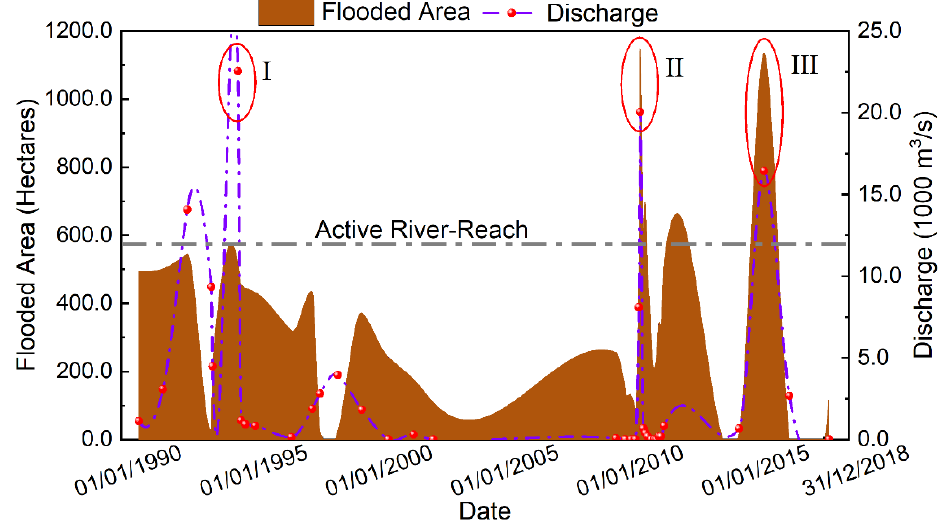
Figure 6. The relation between riverine surface area inundated with water and corresponding discharge: (I) Water-inundated area below active river reach area at exceptionally high flood, i.e., 22,550 m 3 /s; (II) Water-inundated area above active river reach area at exceptionally high flood, i.e., 20,055 m 3 /s; (III) Water-inundated area exceed active river reach area at high flood, i.e., 16,437 m 3 /s.